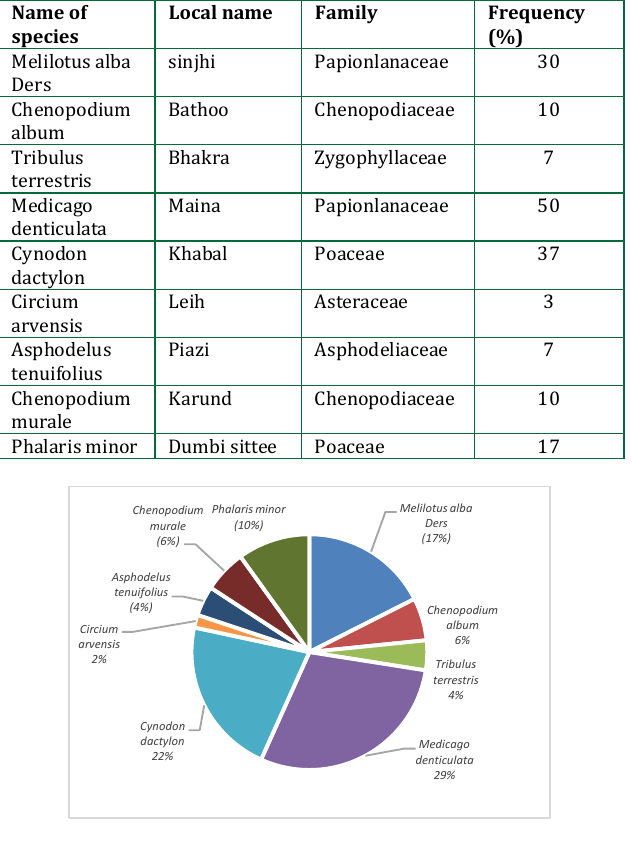
Table 5: Frequency (%) of weed infesting the wheat field of Karor Lali e son District Layyah Name of species